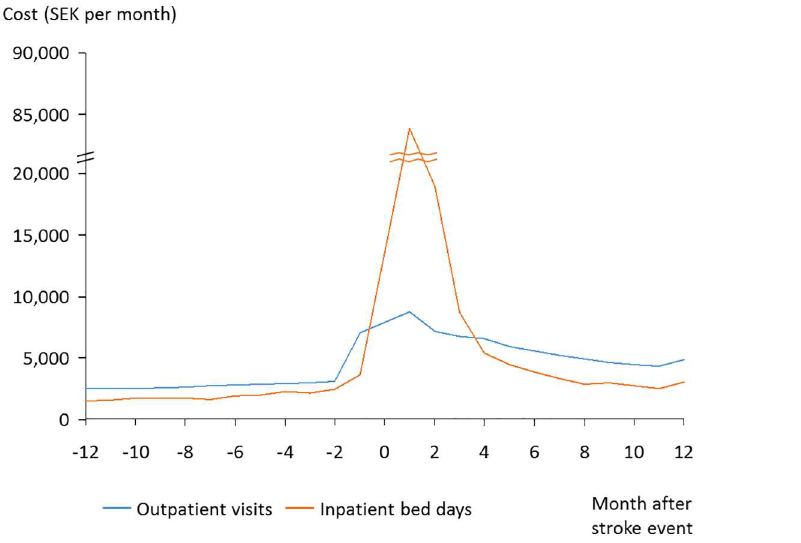
Fig 3. Resource use prior to and after stroke